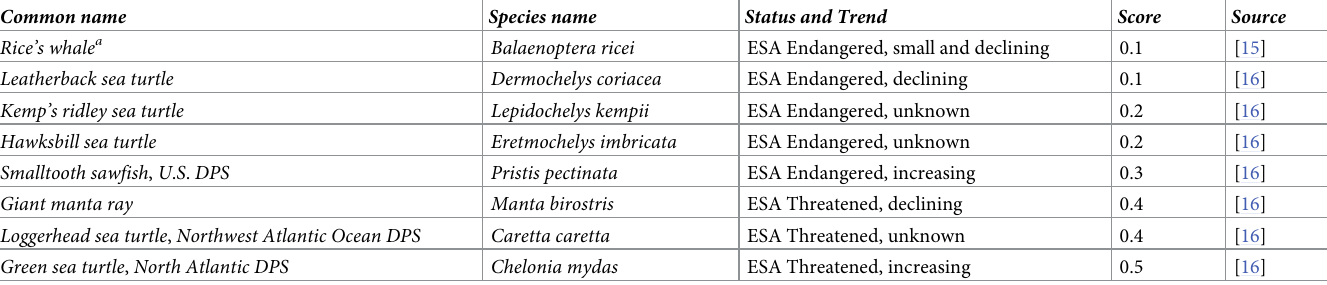
Table 2. Suitability scores for endangered species act listed species occurring in the Gulf of Mexico aquaculture atlas study